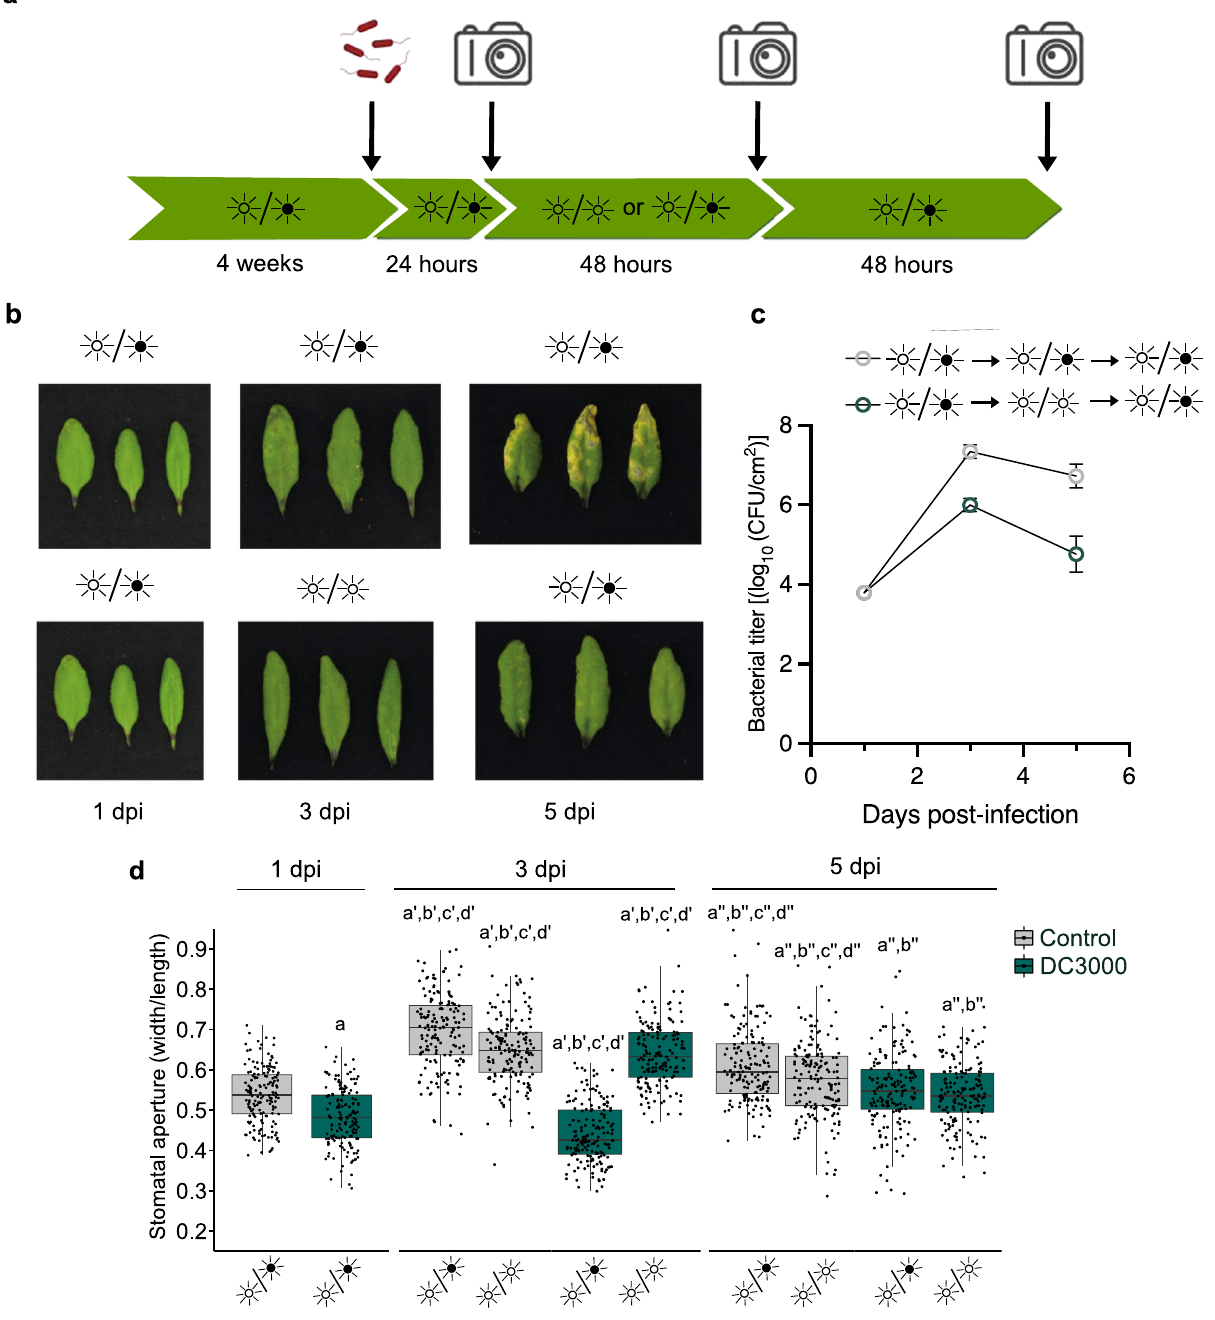
Fig. 5 | Constant light can prevent disease development. a Schematic diagram representing treatments and phenotype assessment of light-mediated disease pre- vention. This fi gure was created with BioRender.com. b Disease symptoms in Ara- bidopsis plants infected with 1×10 5 CFU/ml under different light settings, as, indicated. c Bacterial titers from plants shown in b and harvested at the indicated timepoints ( n =3 biologically independent replicates). Bacterial titers were sig- ni fi cantly different between plants subjected to a LL treatment versus control (Stu- dent ’ s t test, p =0.0024) d Stomatalaperturemeasurementsofleavesevaluatedasin